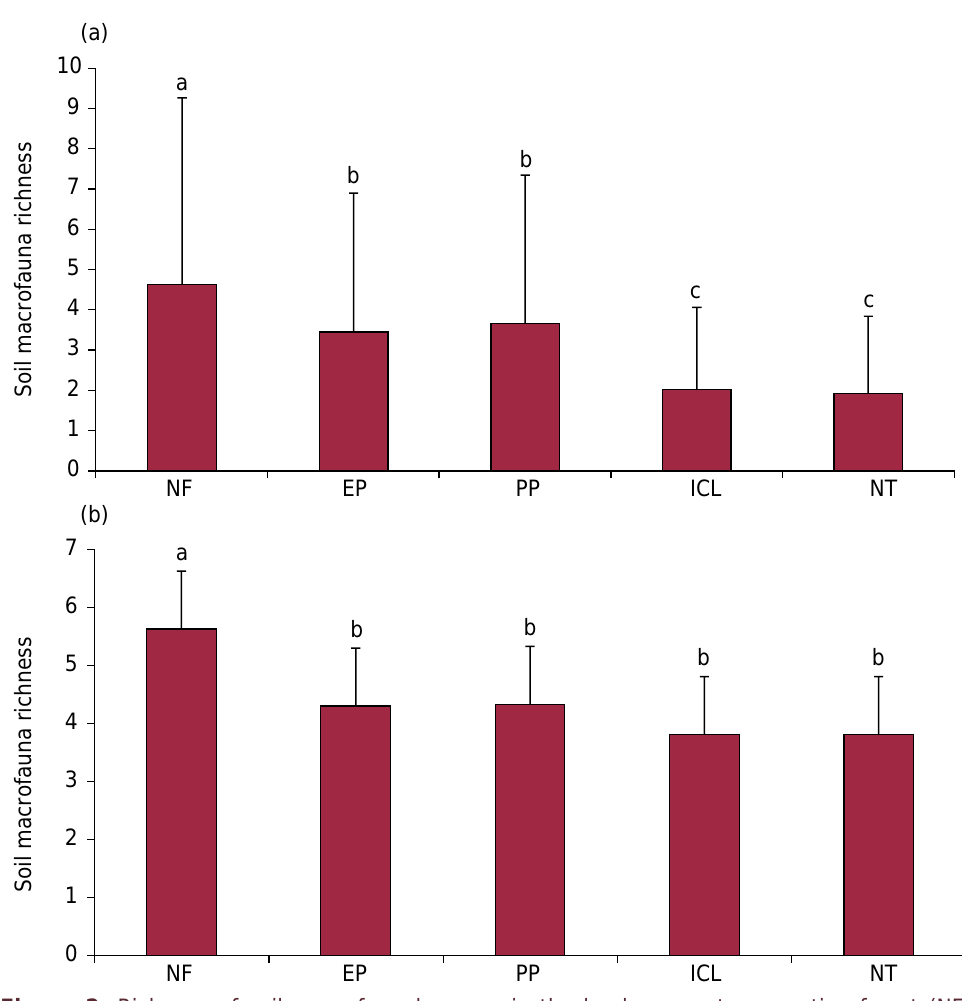
Figure 2. Richness of soil macrofaunal groups in the land use systems: native forest (NF), eucalyptus plantations (EP), perennial pasture (PP), integrated crop-livestock (ICL), and no-tillage (NT) in the summer (a) and winter (b), in the eastern region of Santa Catarina, Brazil. Different letters above the bars reflect statistical difference using the t test (p<0.05) and line bars are standard